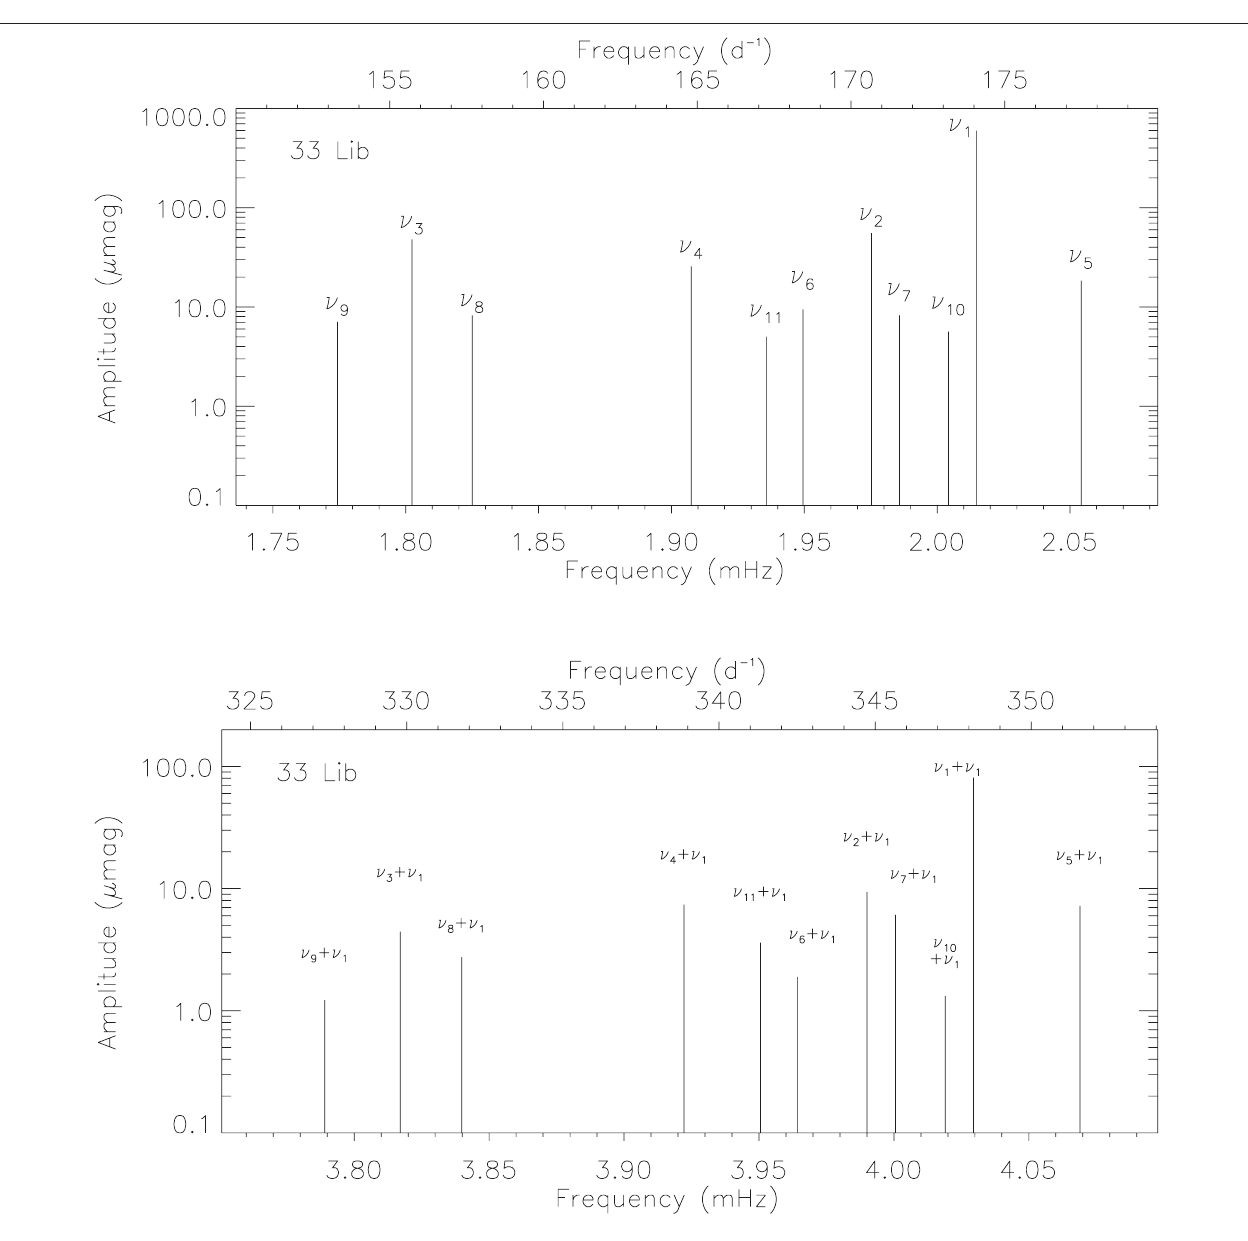
FIGURE 8 | (Top) Schematic view of the pulsations in 33Lib. Note the logarithmic amplitude scale. (Bottom) schematic view of the pulsations around the harmonic. Note that the separation between the modes is the same in the two plots, and not twice in the bottom plot as one would expect.